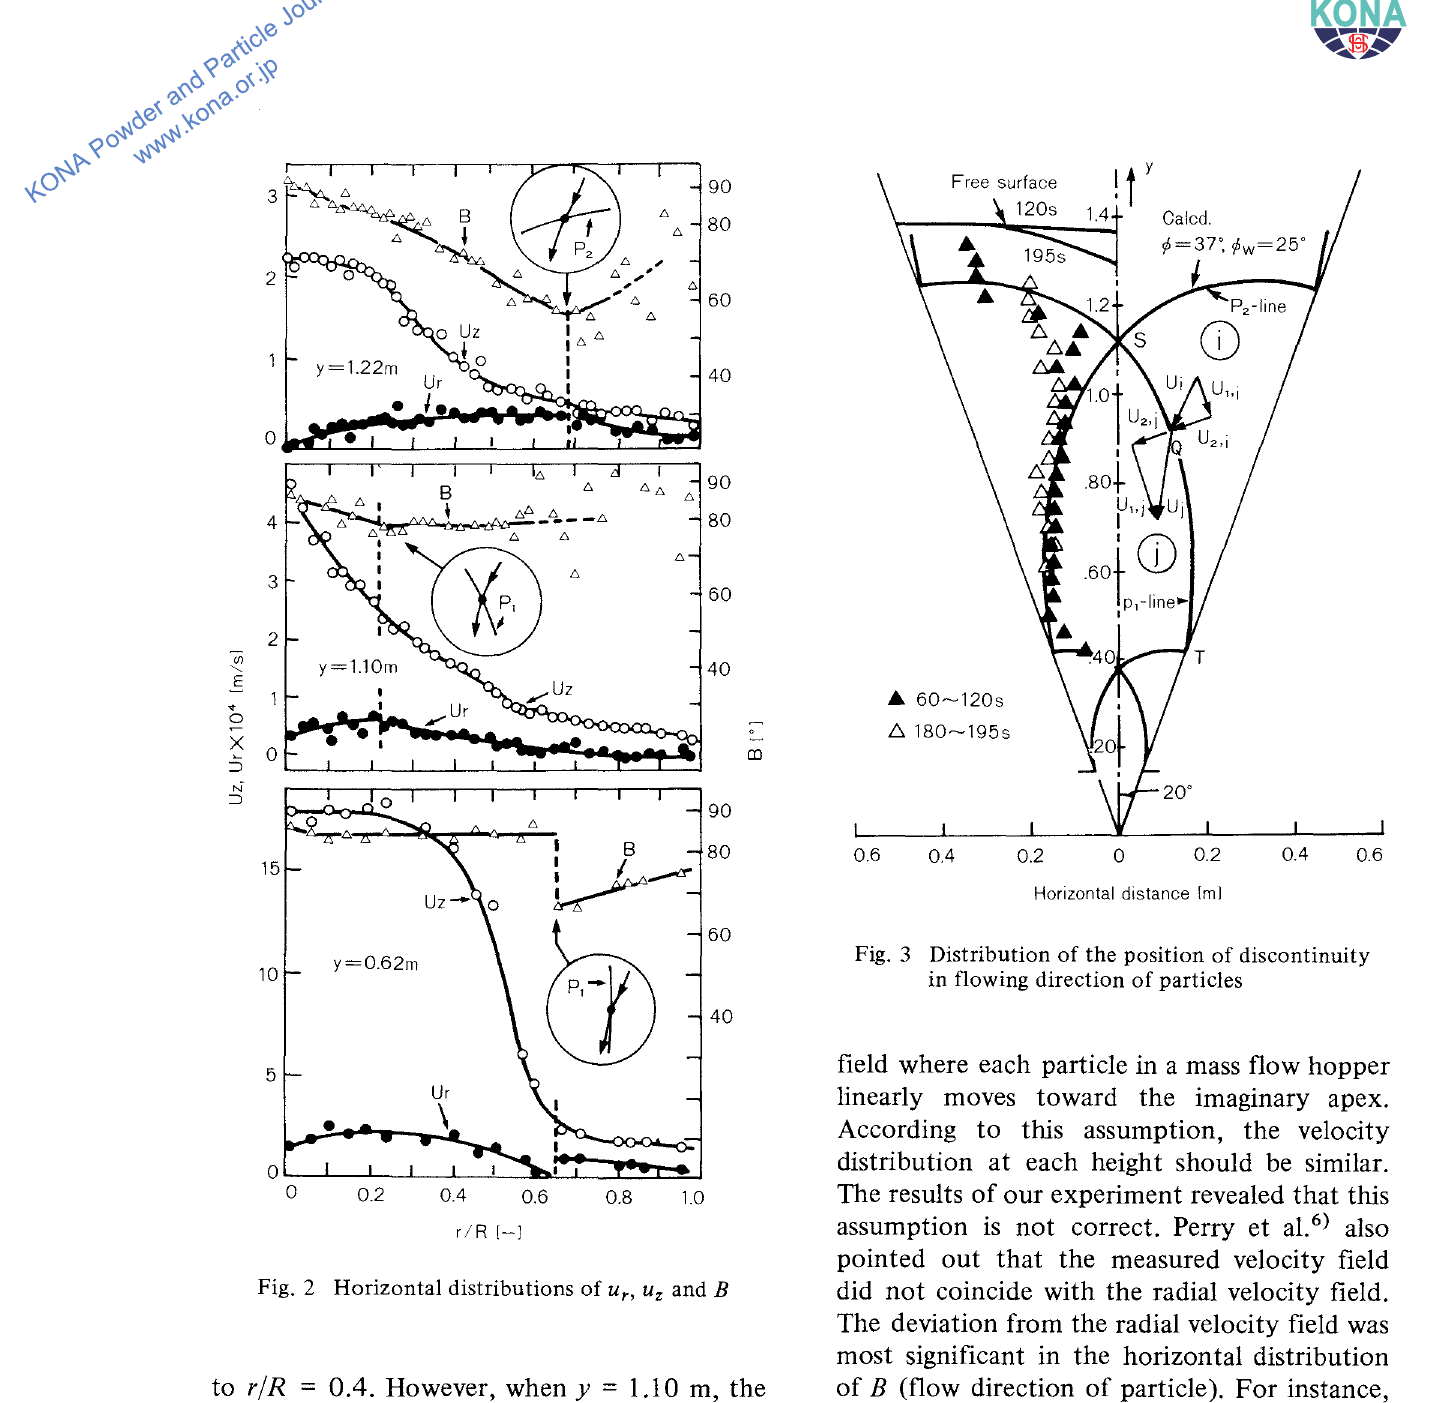
to r/R = 0.4. However, when y = 1.10 m, the Uz value sharply decreases with an increase in the distance from the center line of the hopper.